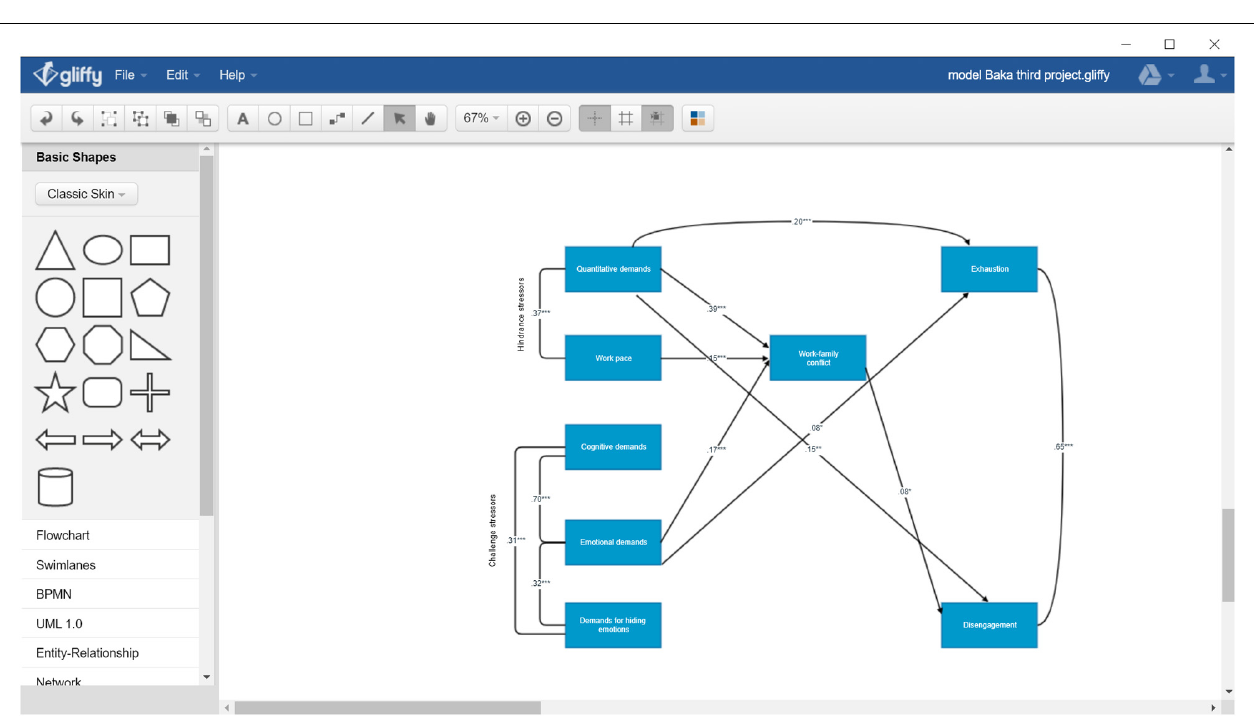
FIGURE 1 | Hypothesised model for the link between various job demands and job burnout in two forms including additional mediational effects. Non-significant paths are not included. Standardised coefficients are presented. Some coefficients of covariance were omitted for clarity. The magnitude of intercorrelations between constructs could be found in Table 1